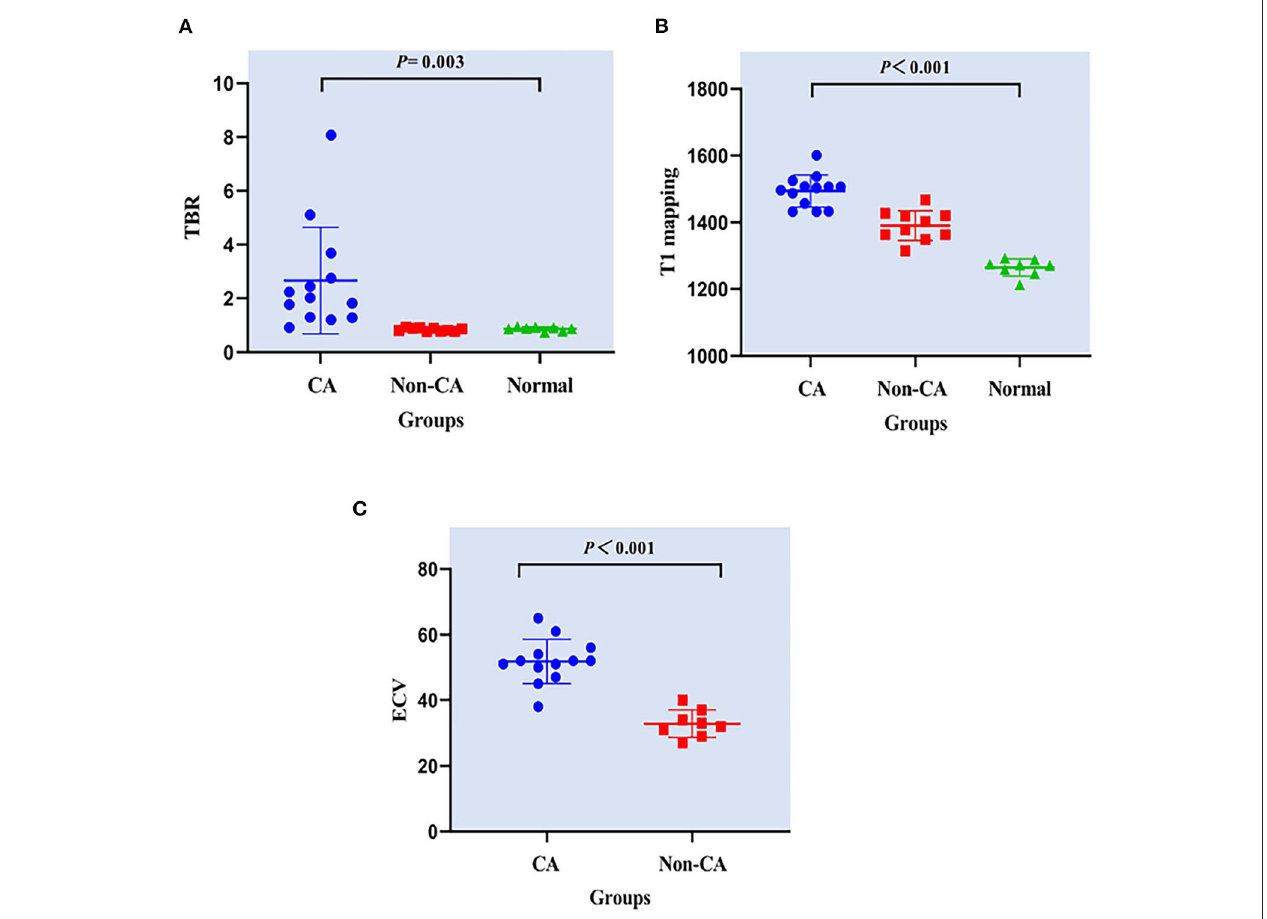
FIGURE 1 | Comparison of (A) TBR, (B) T1 mapping, and (C) ECV values between CA patients, non-CA patients, and healthy control subjects. CA, cardiac amyloidosis; TBR, maximum target-to-background ratio; ECV, extracellular volume. (A) PET data showed that the TBR was significantly higher in the CA patients compared with the non-CA patients and healthy subjects (2.66 ± 1.99 vs. 0.85 ± 0.06 vs. 0.88 ± 0.07; P < 0.05). (B) The native T1 values were significantly higher in the CA patients compared with the non-CA and healthy subjects (1493.9 ± 48.1 vs. 1390.3 ± 44.8 vs. 1264.6 ± 25.6; P < 0.05). (C) The ECV values were significantly higher for the CA patients compared with the non-CA patients (51.9 ± 6.7 vs. 32.9 ± 4.2; P < 0.05).